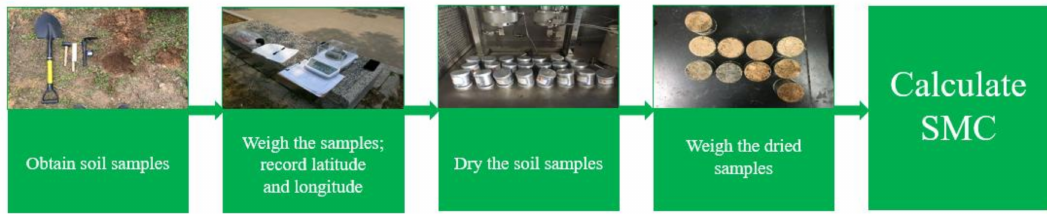
Figure 2. The experimental procedures for obtaining soil samples and calculating the soil moisture content (SMC).